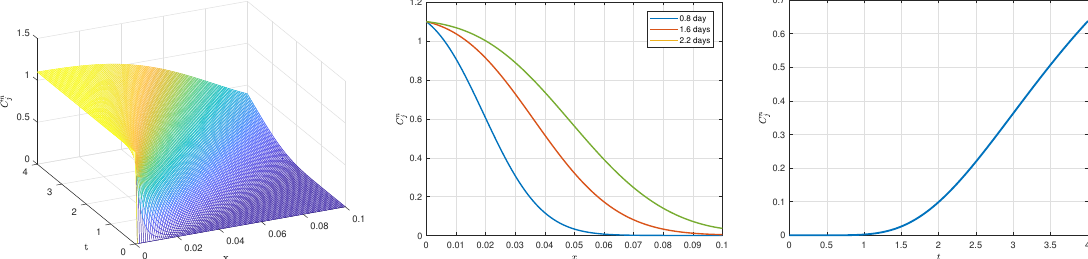
Figure 8. Numerical simulations obtained with α = 1. Left frame: H 2 concentration along axial direction at different space and time; Middle frame: the concentration profile of 0.8, 1.6, and 2.2 days; Rigth ram: H 2 profile at point x = 0.08 of the Zr 2 Fe